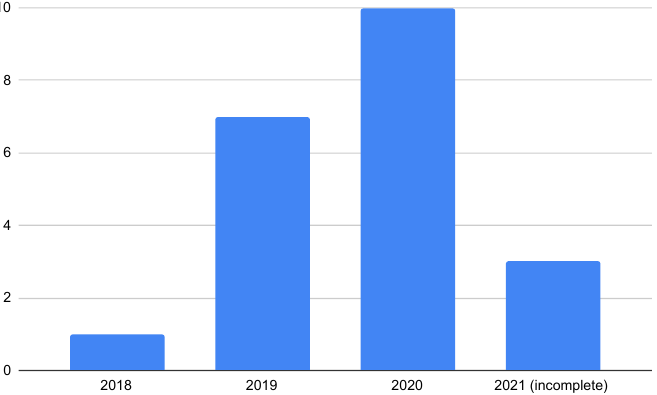
Figure 3. Number of published papers on blockchains for BGP per year. The plot refers to all papers of projects included in this study.